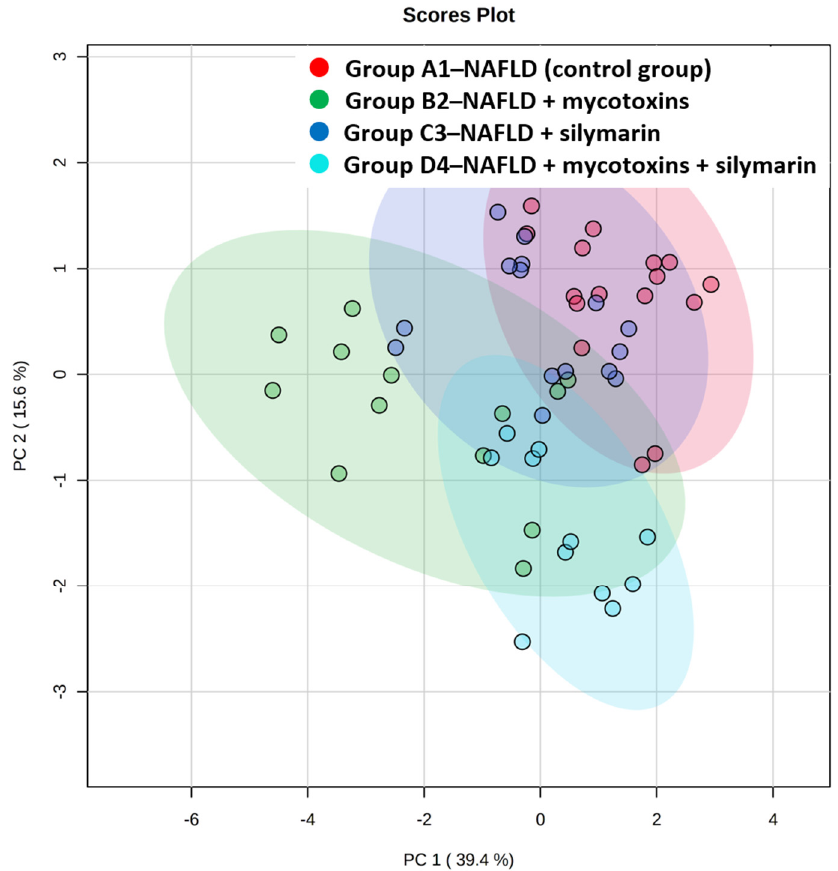
Figure 1. PCA score plot of 92 MS/MS confirmed lipids filtered out by ANOVA FDR p -value < 0.01. As the next step, three binary OPLS-DA models were built to identify the sets of the most significant lipids having the greatest influence on separation of the experimental groups. Groups B2, C3 and D4 were consecutively compared with the control group (B2 vs. A1, C3 vs. A1 and D4 vs. A1), and all lipids with OPLS-DA VIP score > 1 were selected. The three partially overlapping subsets of 38, 29 and 33 lipids for ‘B2 vs. A1 ′ , ‘C3 vs. A1 ′ and ‘D4 vs. A1 ′ , respectively, are summarized in Tables S3–S5. From these sets, 28 lipids that significantly contributed to groups separation in at least two binary comparisons were selected. The fold changes of these lipids between the particular sample groups are summarized in Table 3, and depicted in the Figure 2 radar chart (in the Figure S2, boxplots and more, in particular C18: 1, C18: 2, C18: 3, C20: 4, C22: 3, C22: 5 and C22: 6. The intervention of silymarin/mycotoxins administration caused upregulation of triacylglycerols (TGs), diacylglycerols (DGs), free fatty acids (FAs), fatty acid esters